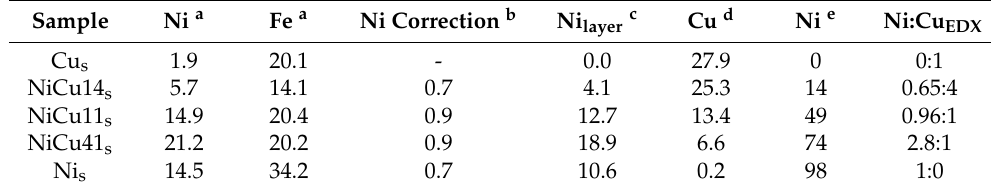
Table 2. Ni and Cu concentrations in the layers deposited on meshes in at.% (determined by EDX).